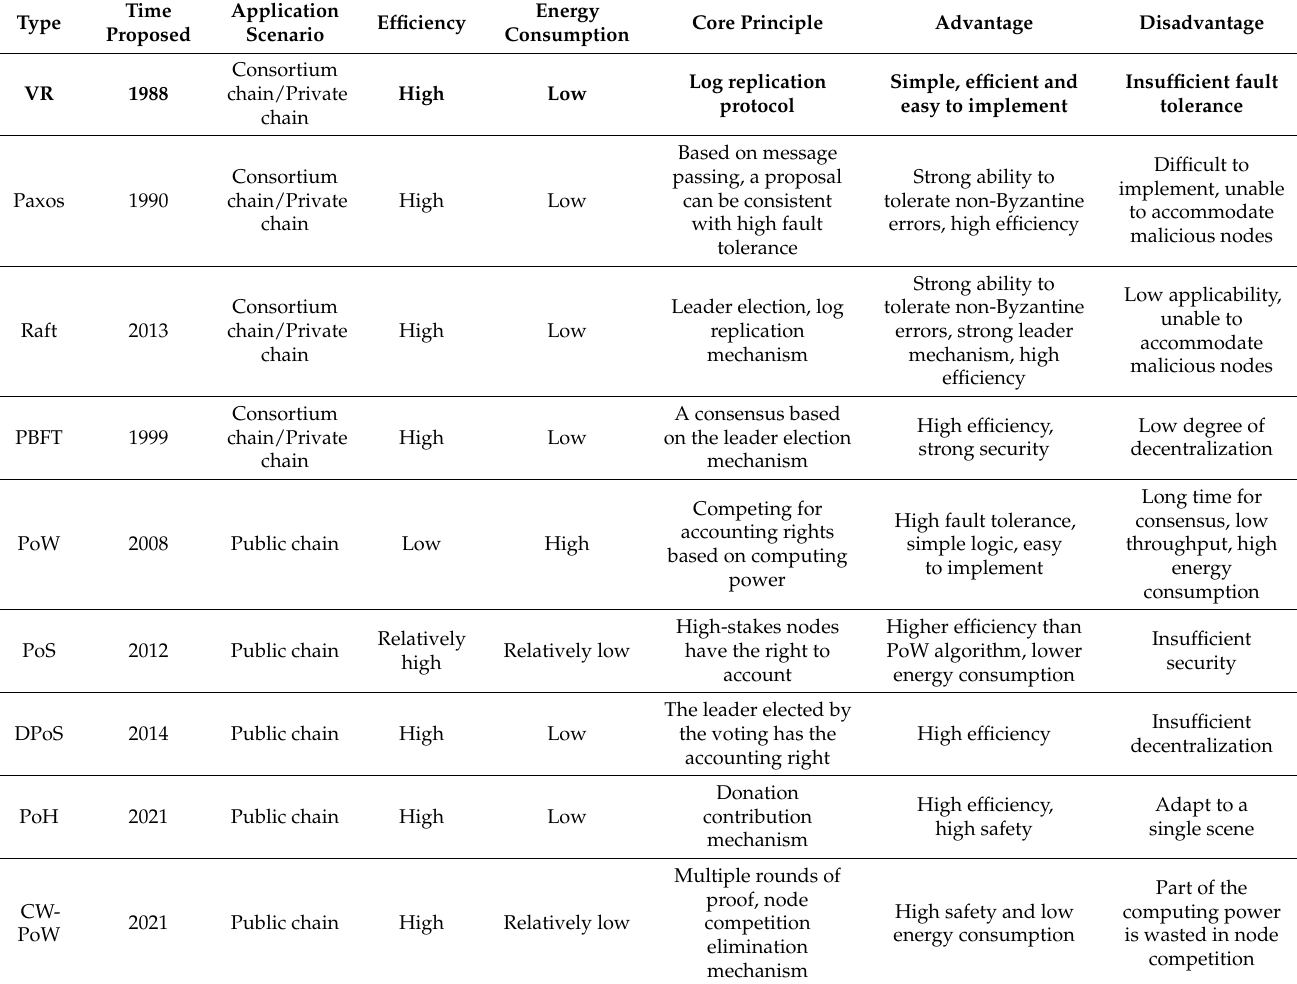
Table 2. Comparative analysis of typical blockchain consensus